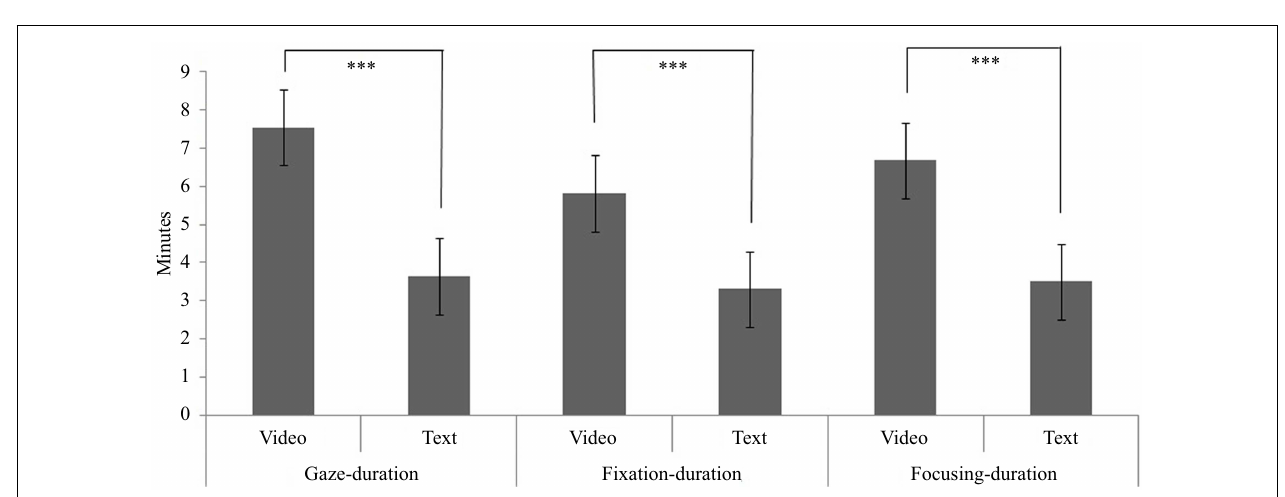
FIGURE 1 | Gaze-, fixation-, and focusing-duration in the feedback area by group (video, n = 20; text, n = 17)